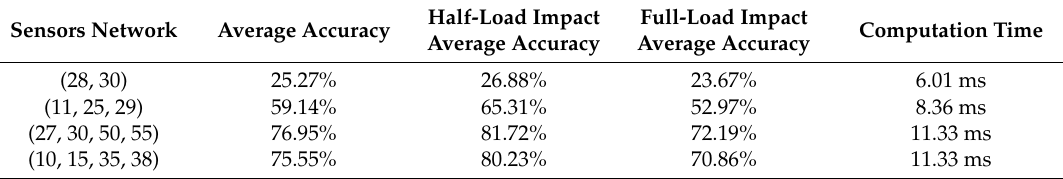
Table 5. Different sensors network impact